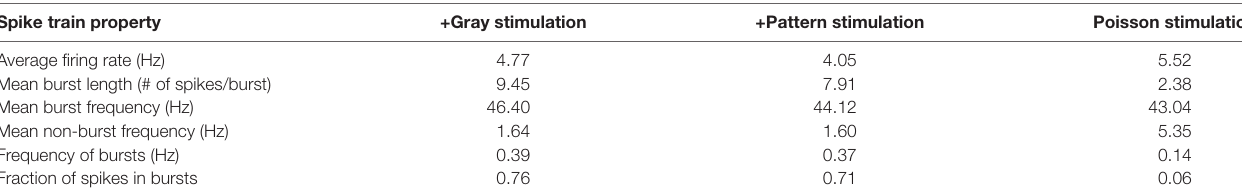
TABLE 2 | Spike train properties of the exemplar cells used for ex vivo stimulations. Spike train